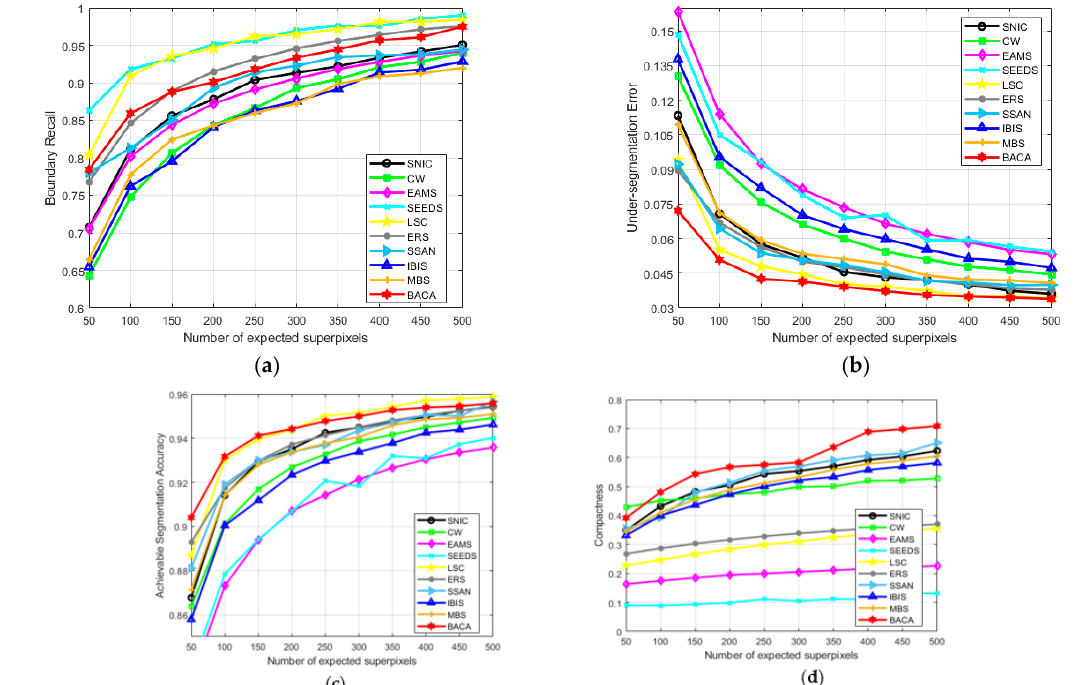
Figure 9. Quantitative evaluation of different algorithms on four evaluation indicators. ( a ) Boundary